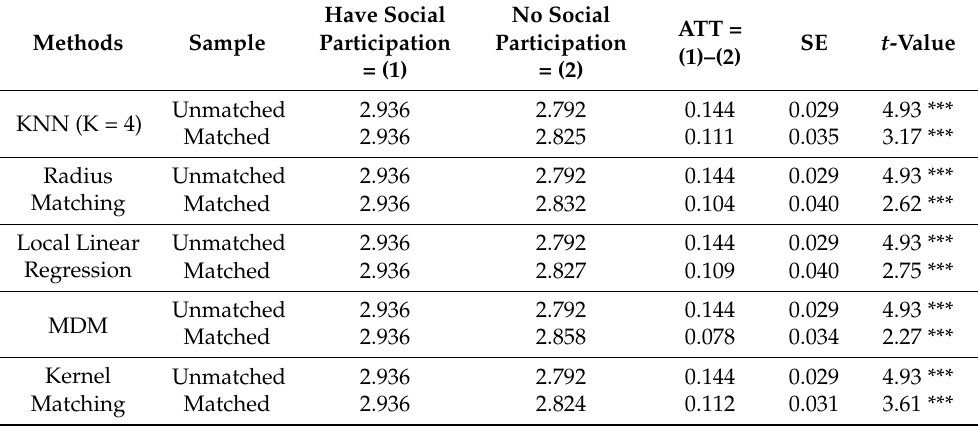
Table 9. Propensity score matching results.